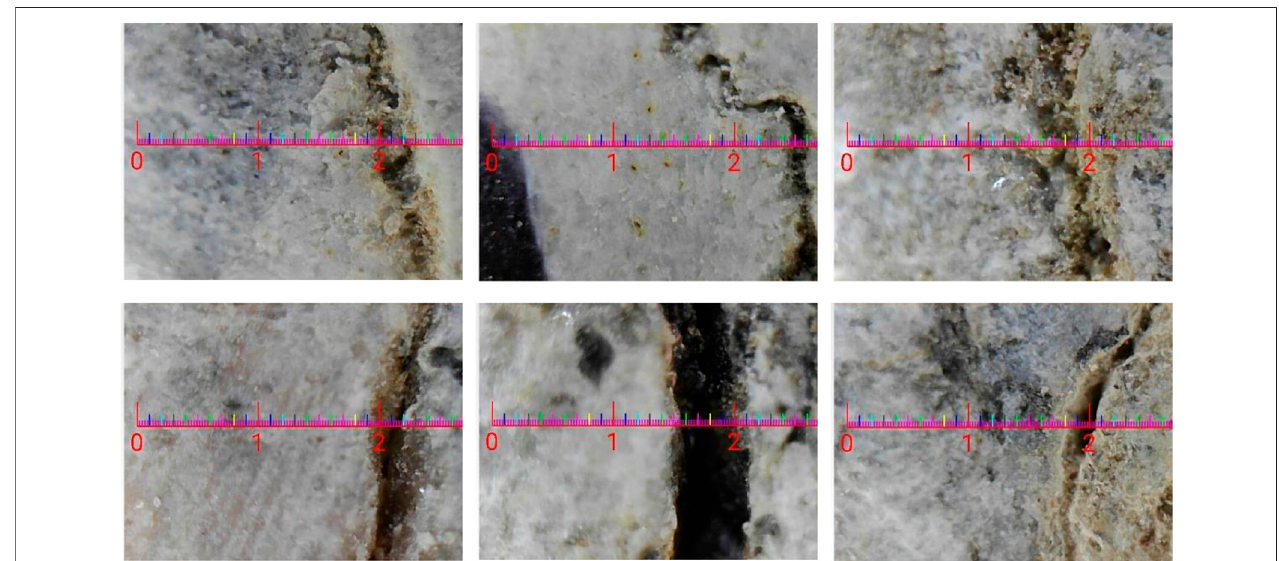
FIGURE 3 | Width measurement map of partial rock samples (units: mm).